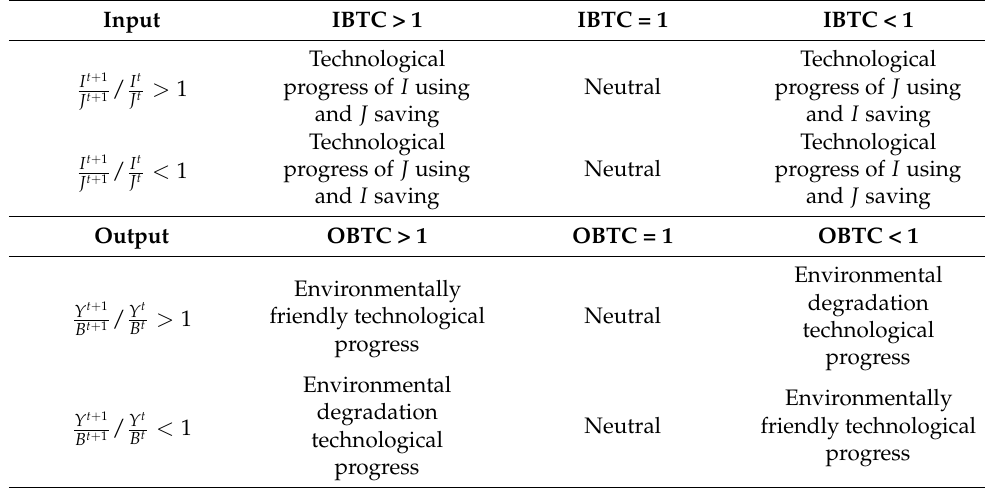
Table 1. Identification method of green technical change